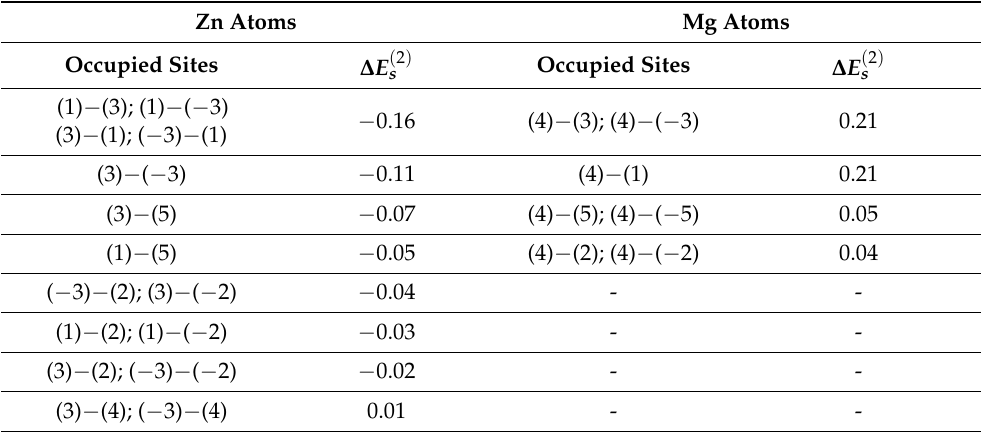
( 2 ) Table 2. Segregation energy ∆ E s (eV) of the second atom (Zn or Mg) in different positions near the Σ 5{013}<100> GB, which contains a Zn atom (at site 1 or 3) or a Mg atom (at site 4).